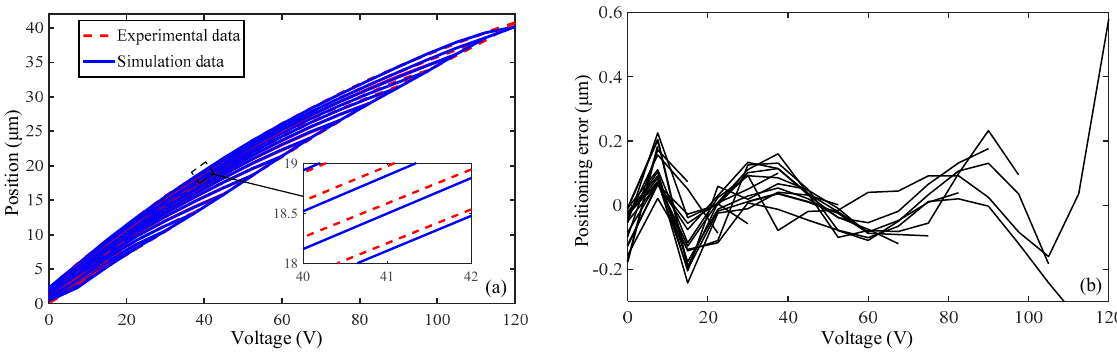
Figure 6. Comparison of the hysteresis loop between the experimental results and the simulated results: ( a ) hysteresis loop, ( b ) hysteresis error.